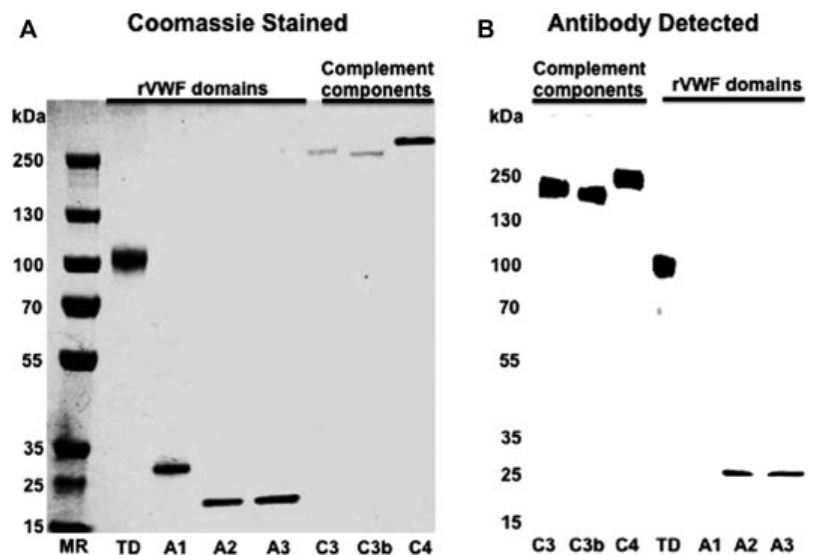
Fig. 1 Gel display of VWFand complement proteins. In ( A ) recombinant human VWFA1A2A3 (TD), individual VWFA1, A2, and A3 domains, and puri fi ed human C3, C3b, and C4 were electrophoresed into a 4 – 12% SDS-polyacrylamide gradient gel (top left panel) and the protein bands were stained with Coomassie Blue. In ( B ), the same samples as in ( A ) were transferred onto an Immobilon-P transfer membrane (PVDF), and detected using rabbit anti-VWF plus secondary goat anti-rabbit-HRP; or with goat anti-C3 (for C3 and C3b) or goat anti-C4 plus secondary rabbit anti-goat- HRP. (Note: our rabbit polyclonal anti-VWF antibody does not detect the VWF A1